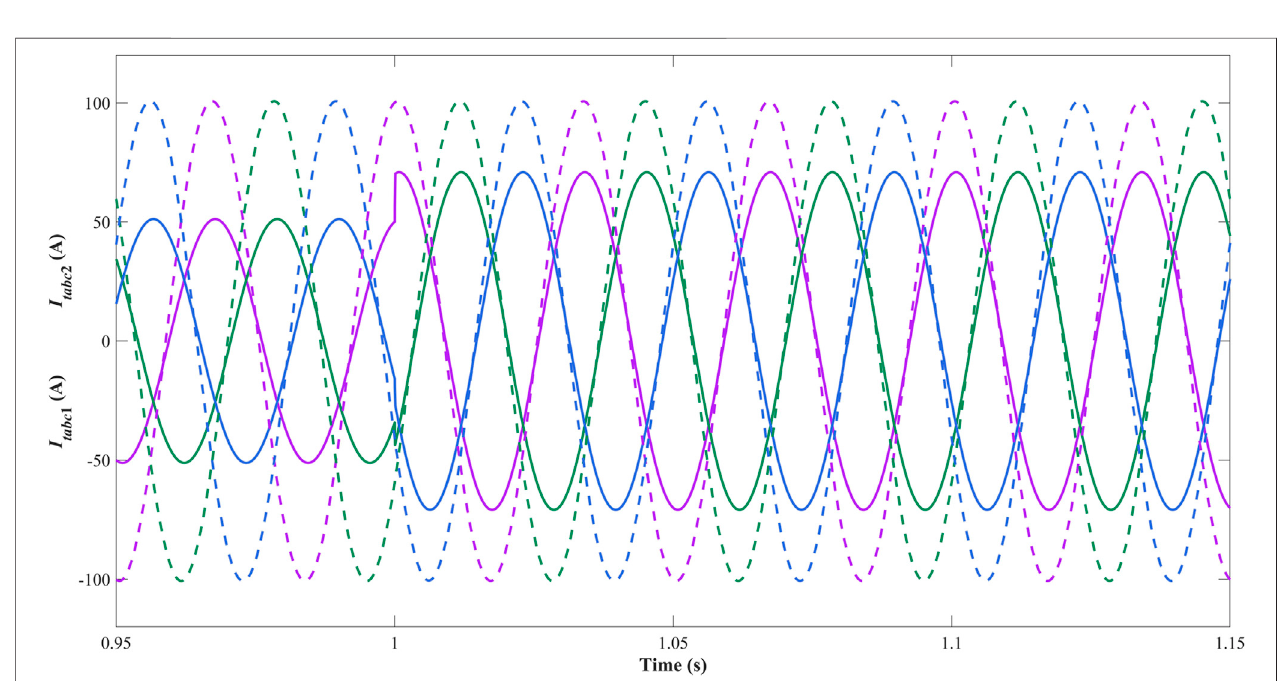
FIGURE 8 | Three-phase waveforms of currents generated from DGu1 and